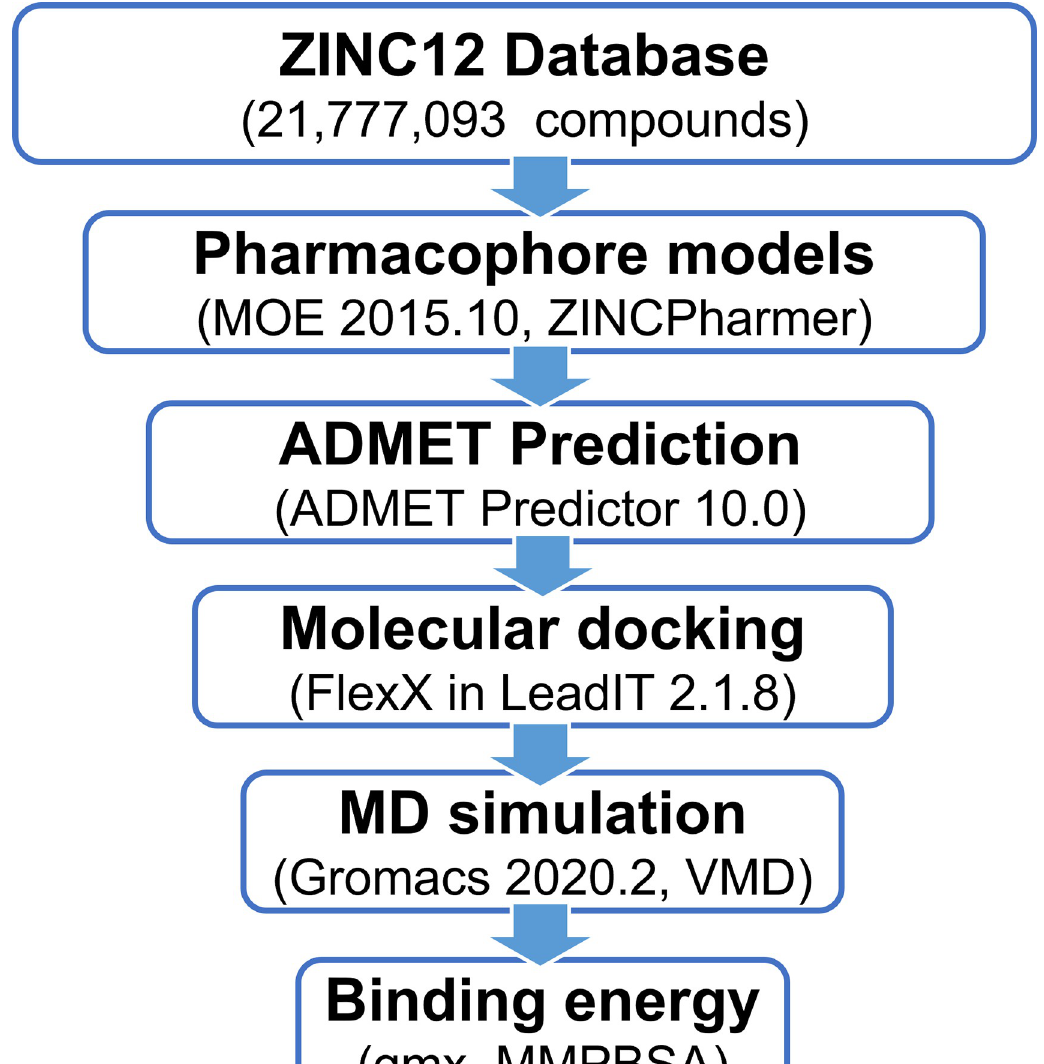
Fig 1. Study flowchart.